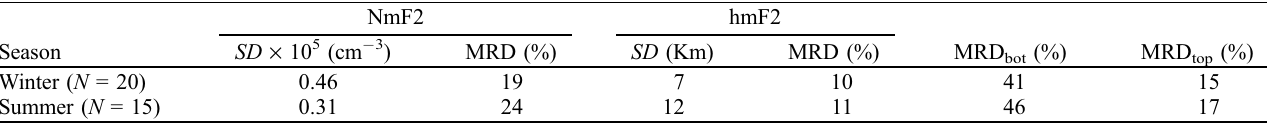
Table 3. Statistical results of the Millstone Hill ISR/COSMIC RO comparison obtained from the data given in Tables 1 and 2. Average mean relative deviations after the comparison of the bottom side and the topside of EDP are given as